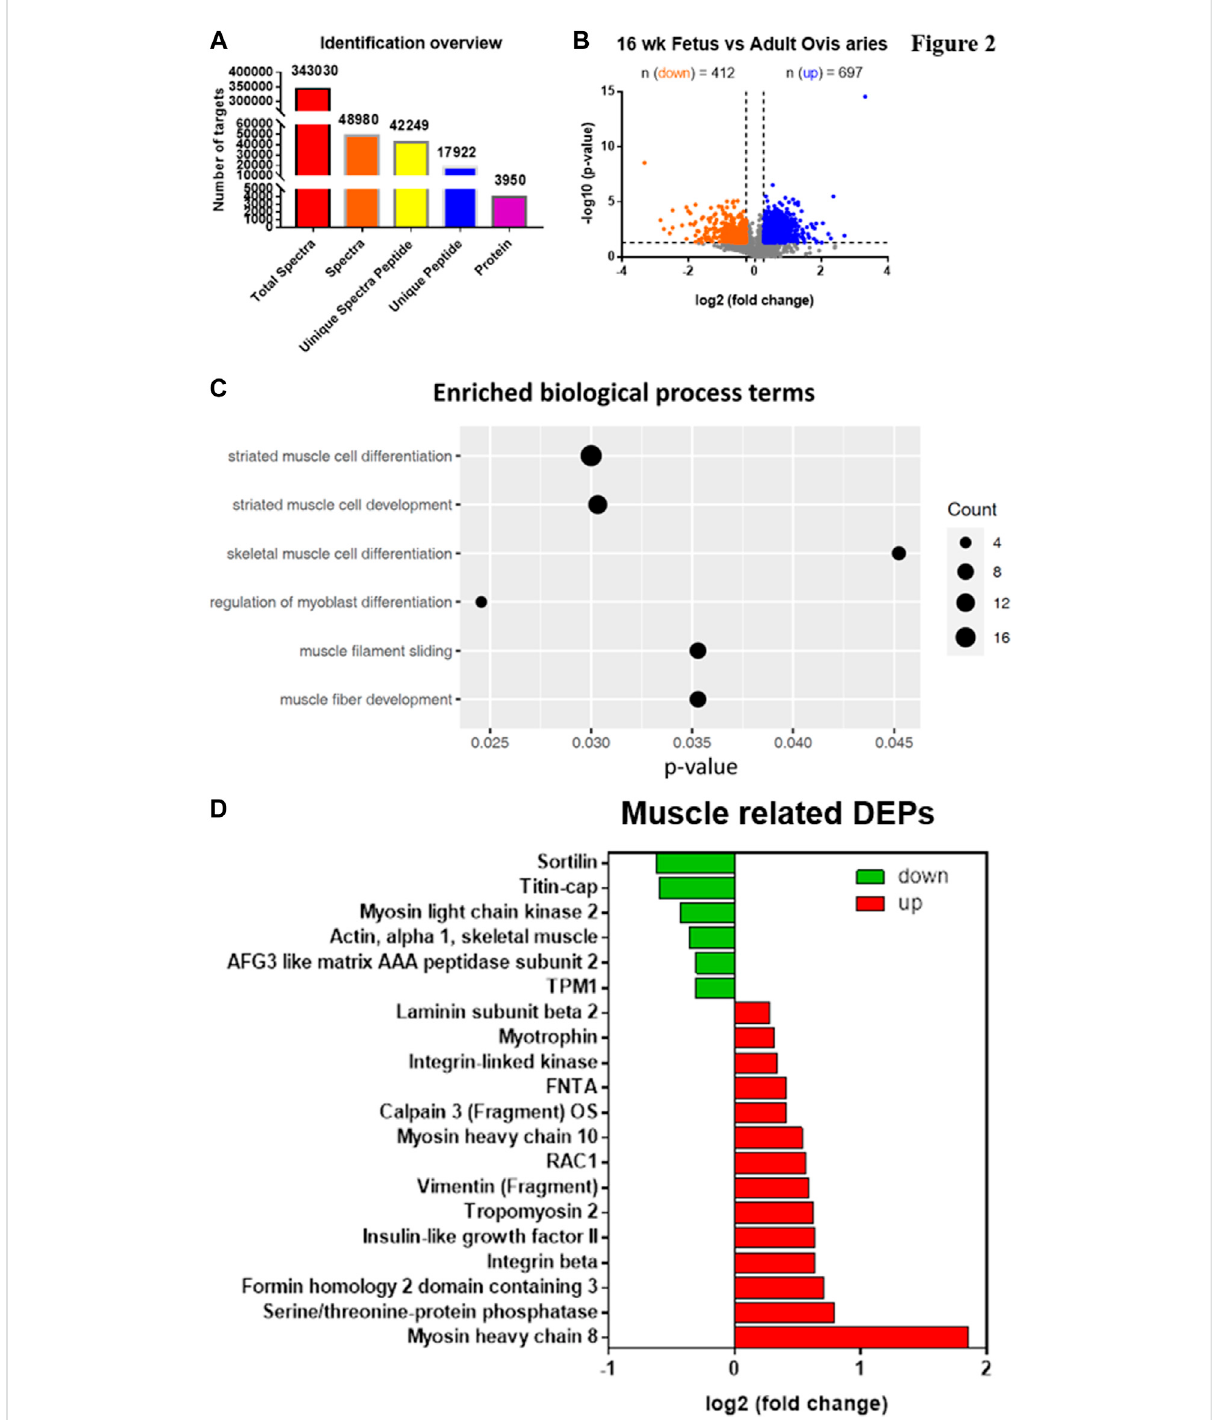
FIGURE 2 iTRAQ analysis of FSME and ASME proteomic expression pro fi les. (A) Analysis of the number of differentially expressed proteins between FSME 16-week-old fetal sheep and ASME of adult sheep. 3,950 proteins are identi fi ed in FSME and ASME. (B) Volcano plot of the relative quantitation results. A t -test was used between groups. Proteins with a ratio of < 0.83 or > 1.2 and p value < 0.05 were considered as differentially expressed proteins. Orange and blue plots indicate downregulated and upregulated differentially expressed proteins, respectively. Grey plots represent non-signi fi cant proteins. Amongst 3,950 proteins, 697 proteins are signi fi cantly upregulated while 412 proteins are signi fi cantly downregulated. (C) For the GO enrichment analysis, there are a total of 203 biological process terms enriched signi fi cantly. Among these, six of them are related to muscleormusclelineagecells.SizerepresentsthecountofDEPsannotatedtotheGOterms. (D) Intotal,thereare20DEPsannotatedforthesixGO terms. Green and red bars indicate downregulated and upregulated differentially expressed proteins,